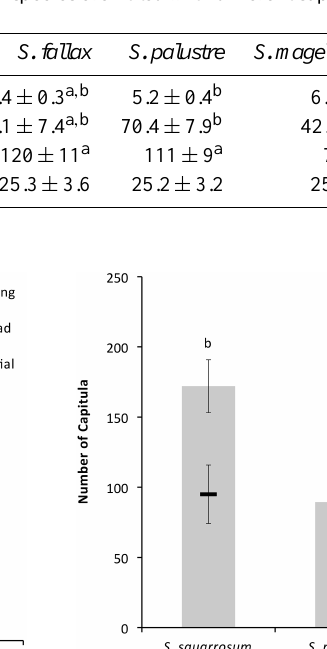
Table 3. Characteristics of the different Sphagnum moss patches, including pH within the vegetation (0.5–1cm above soil level; measured after 6 weeks of growth), and final data (after 12 weeks) on C:N ratio, length of the moss fragments and cover of the patches. For all variables, P values are given and significant differences between species are noted with different superscript letters. ns is not significant.